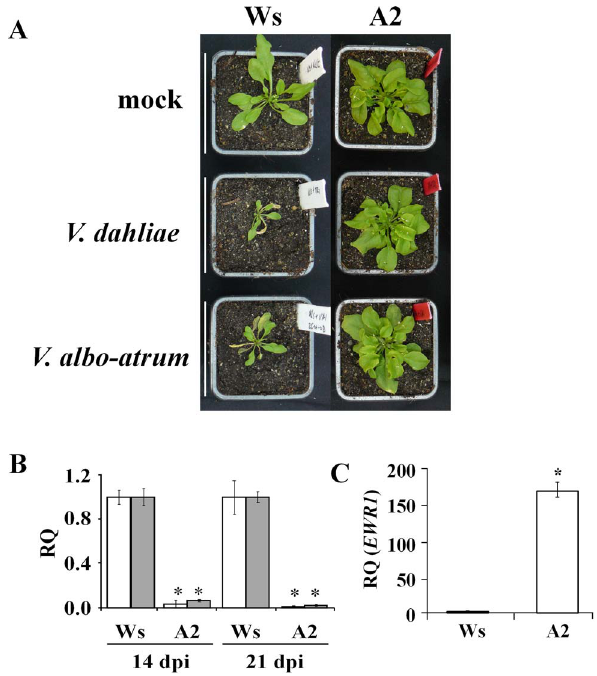
Figure 1. The activation-tagged Arabidopsis mutant A2 is more resistant to V.dahliae and V.albo-atrum . (A) Typical symptoms of Verticillium on the wild-type (WS) and the activation-tagged mutant A2. Picture was taken at 21 days post inoculation (dpi) and a representative of three independent experimental replicates is shown. (B) Relative quantification (RQ) by real-time PCR of Verticillium colonization by comparing levels of the V. dahliae (white bars) and V. albo-atrum (grey bars) internal transcribed spacer (ITS) region of the ribosomal DNA (as measure for fungal biomass) relative to levels of the large subunit of the Arabidopsis RubisCo gene (for equilibration) at 14 and 21 dpi. Bars represent averages with standard deviation of four technical replicates. A representative of three independent experiments is shown. (C) Relative quantification (RQ) of EWR1 transcription level in the wild-type WS and the activation-tagged mutant A2. The bar represents the average of three independent experiments and standard deviation of the means and asterisks indicate significant differences (Dunnett t-test at P=0.01 ) compared to the wild-type WS.